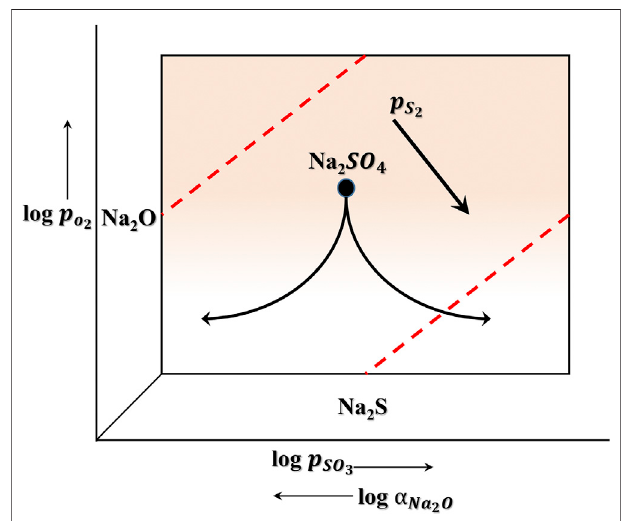
FIGURE 9 | Thermodynamically stable phase diagram of Na-O-S system at constant temperature.